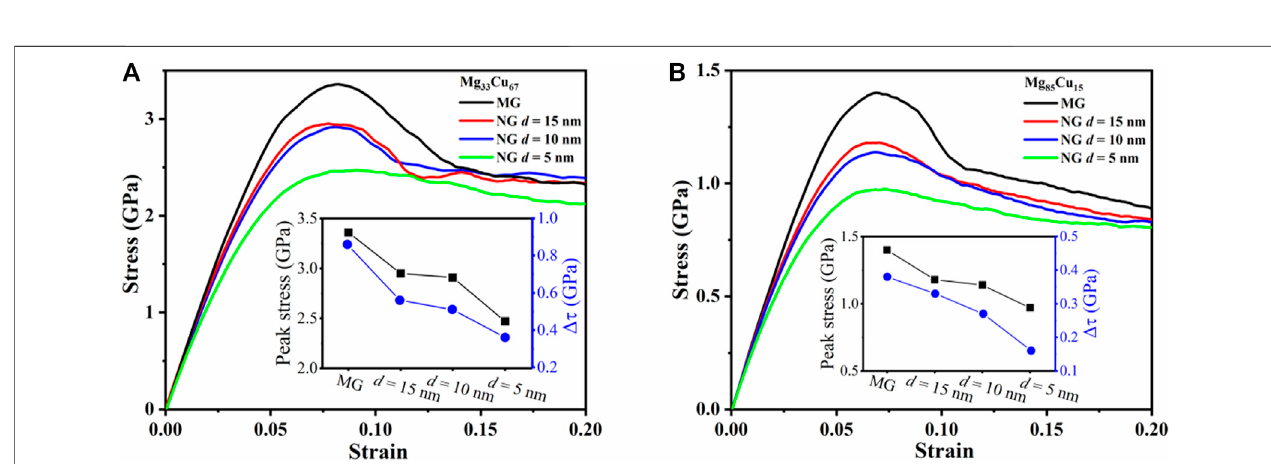
FIGURE 2 | Engineering tensile stress-strain curves for (A) Mg 33 Cu 67 and (B) Mg 85 Cu 15 NGs with d = 15, 10, and 5 nm. MG counterparts are also plotted for comparison. The inset shows the peak stress and Δ τ for MGs and NGs as a function of grain size.